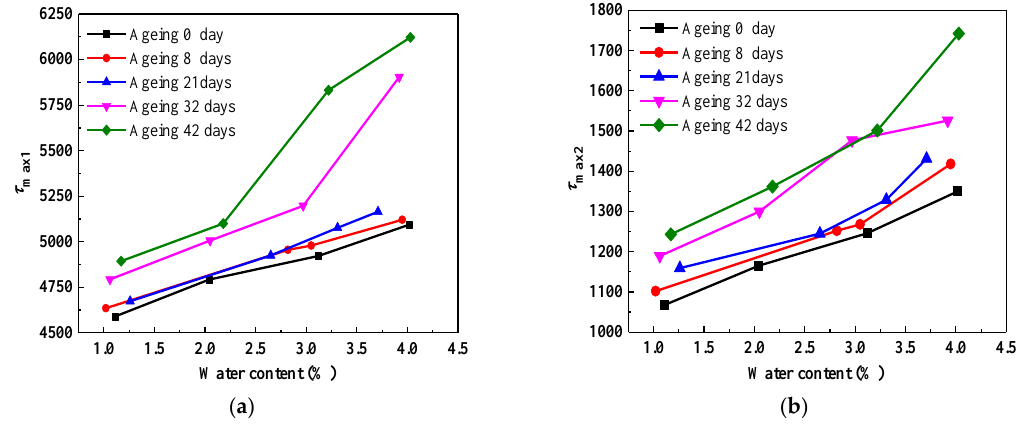
Figure 12. Maximum and second maximum time constants with different water contents. ( a ) τ max1 ; ( b ) τ max2 .